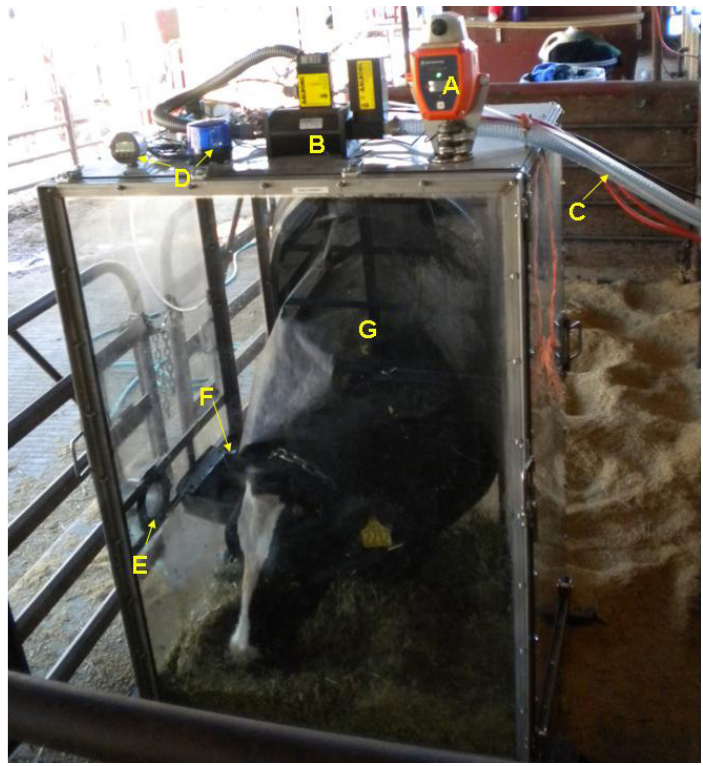
Figure 4. A dairy cow standing and eating during a gas sampling period. (A) is the oxygen sensor/alarm; (B) is the mass flow controller; (C) is the main air line that was connected to the rotary vane vacuum pump; (D) is the differential pressure gage/alarm system; (E) is the air inlet opening; (F) is the water bowl for the cow; (G) is the neck